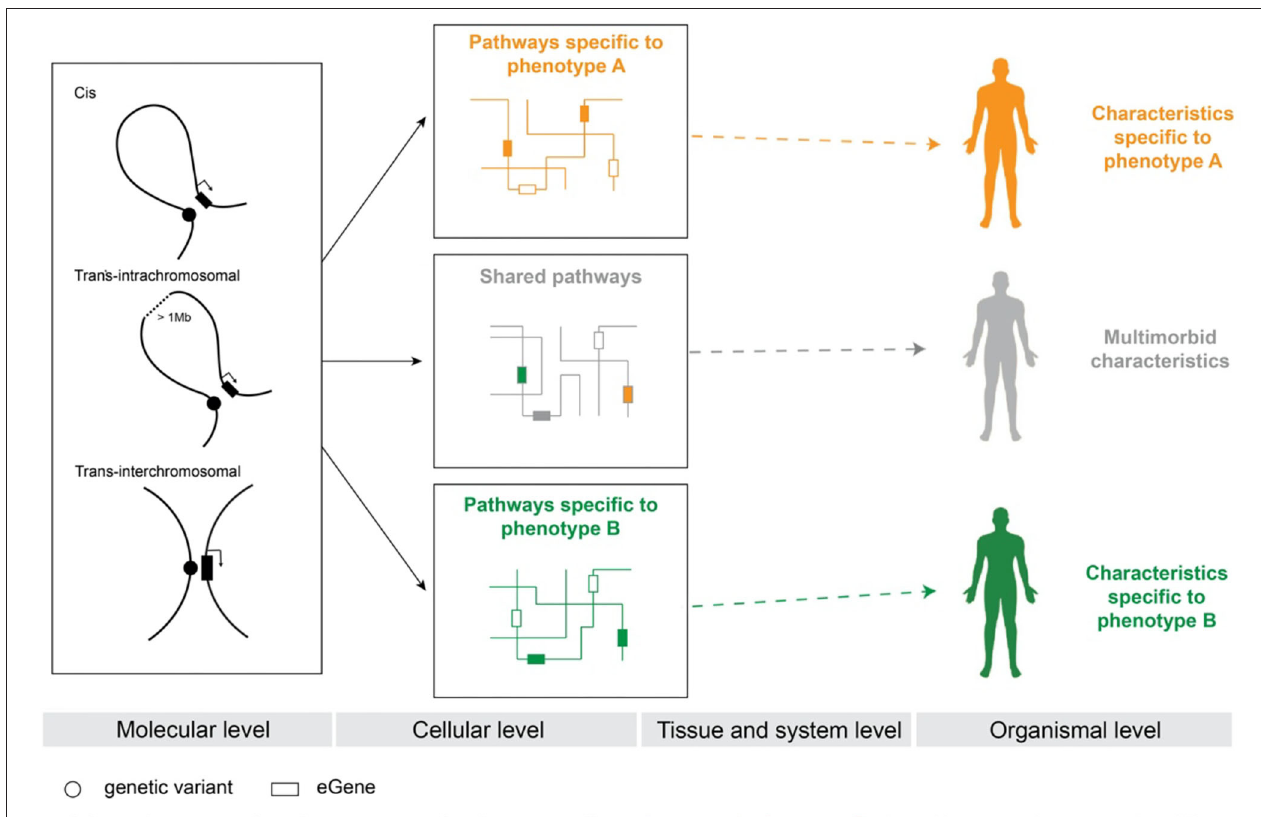
FIGURE 1 | Genetic model of multimorbidity and the SNP-phenotype relationship. Phenotype-specific genetic variants alter tissue-specific gene expression by changing regulatory connections within the 3D dimensional organization of the genome. The gene products, whose expression is altered, interact within biological pathways. Multimorbidity results when affected gene products co-occur within pathways. The co-occurrence of affected gene products within shared pathways changes the way pathways respond to environmental signals and thus affects cellular activities at tissue and system levels. Orange—genetic variants, genes, and pathways specific to phenotype A. Green—genetic variants, genes, and pathways specific to phenotype B. Gray—genetic variants, genes, and pathways shared between phenotypes A and B. White—genes that are not specific to either phenotype A or phenotype